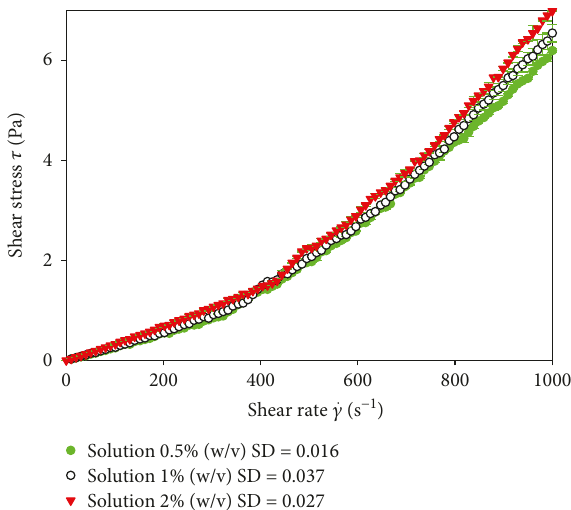
Figure 3: E ff ect of shear rate on viscosity for the three solutions of WGPSE at di ff erent concentrations, at 25 °